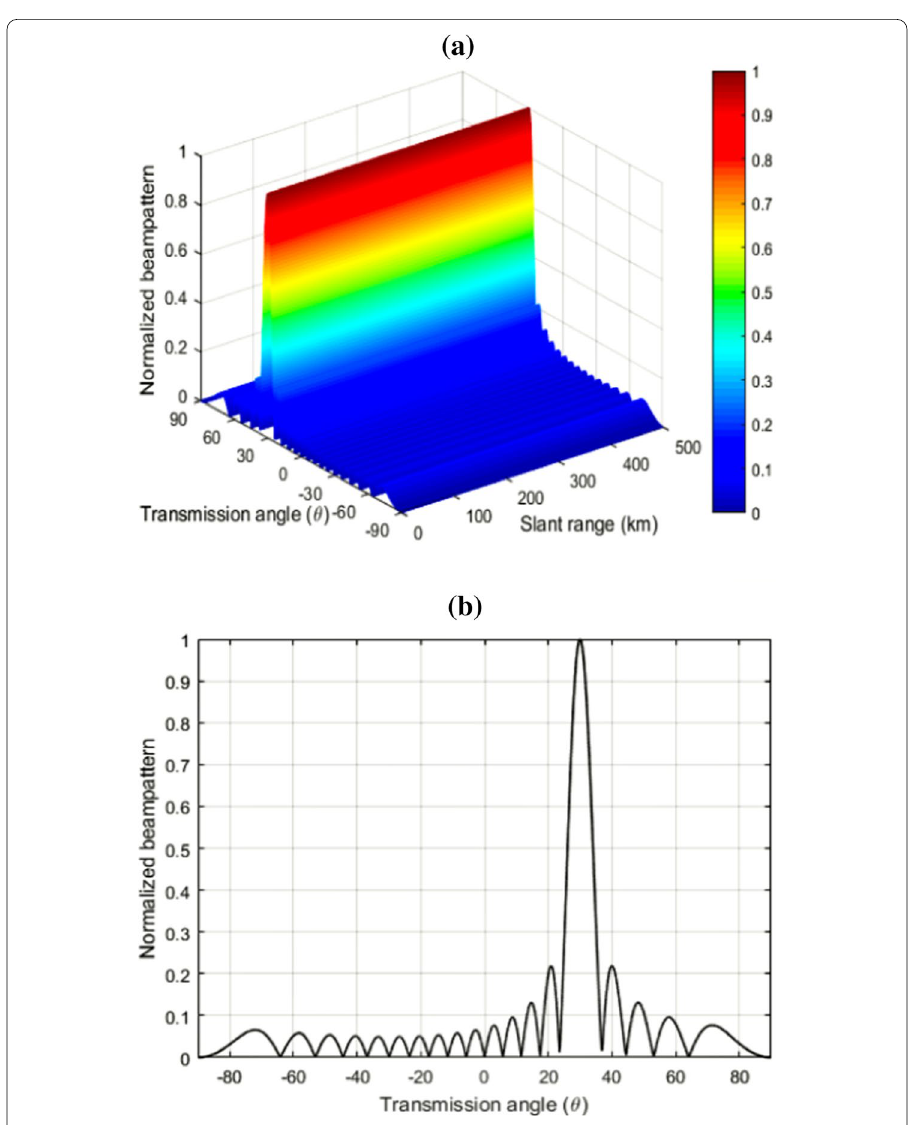
Fig. 2 Normalized beampattern of a 20‑element phased array with scan angle at 30 ◦ . a Range‑angle dimension. b Angle